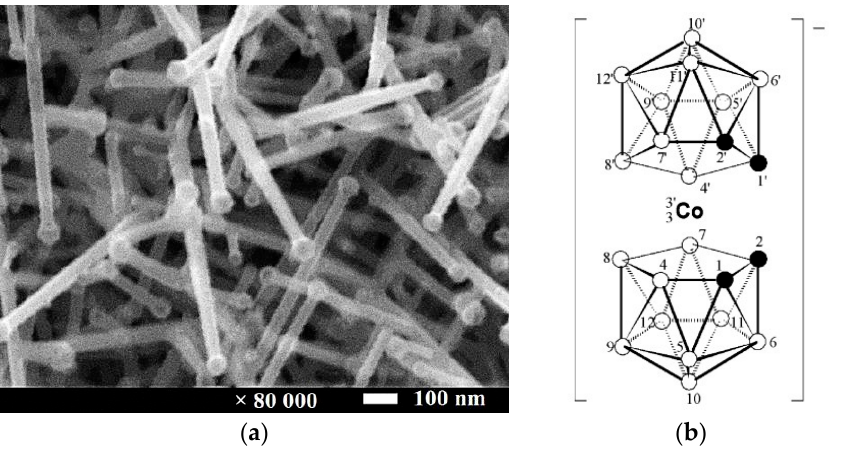
Figure 1. ( a ) SEM micrograph of a transparent nanostructured ITO electrode; ( b ) Chemical structure of the cobaltabis (dicarbollide) [3,3 ′ -Co(1,2-C2B9H11)2] − anion.